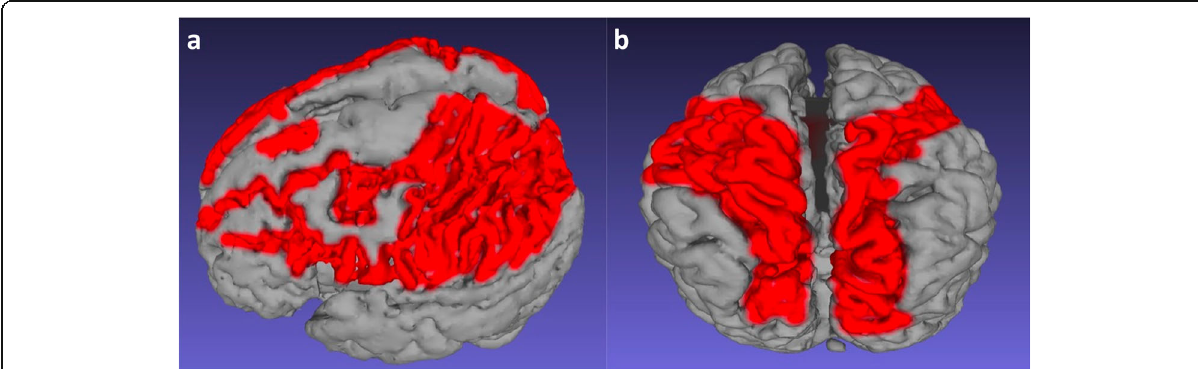
Fig. 14 a , b 3D reconstructions of the brain after skull stripping and segmentation in 2 different children who sustained a partial-prolonged hypoxic-ischaemic injury at term gestation, demonstrating atrophic cortical surfaces in variations of the watershed continuum (painted in red). a